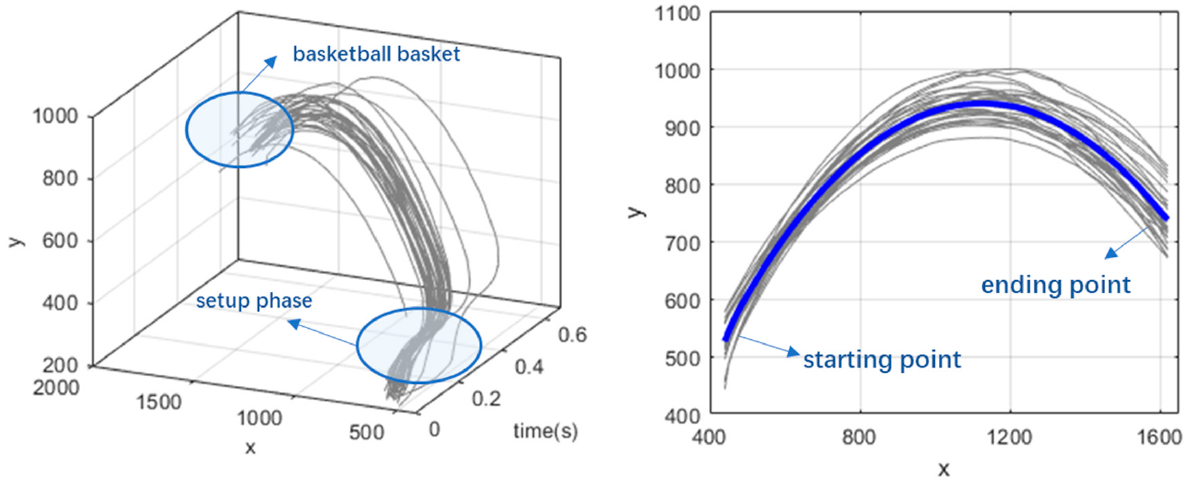
Figure 6. Basketball trajectory in shooting video.